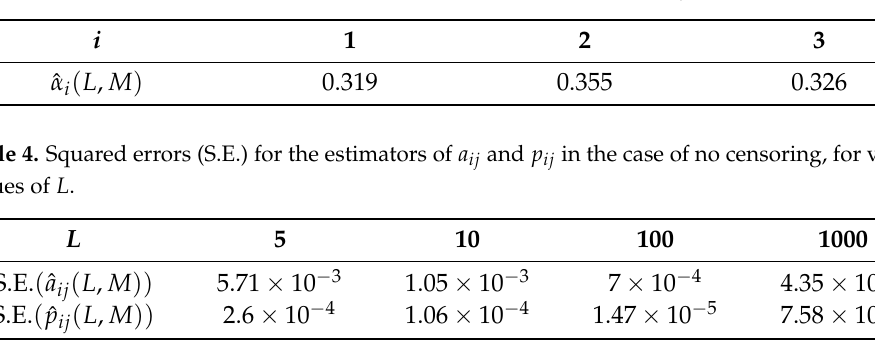
Table 3. The estimated values of the initial law a i in the case of L = 1000 trajectories without censoring.